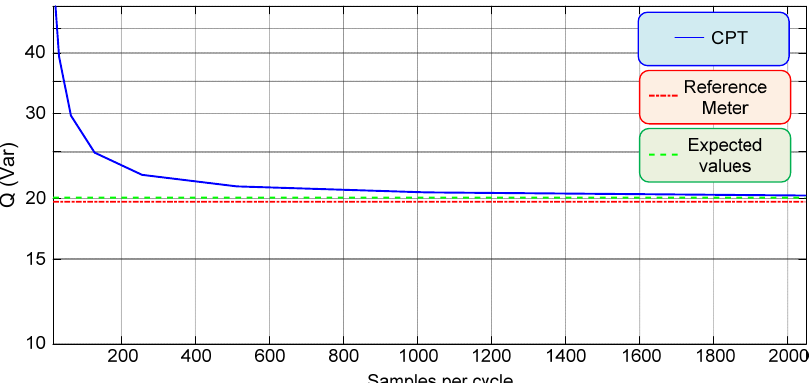
Figure 5. Reactive power for the inductive load with one resistive load.